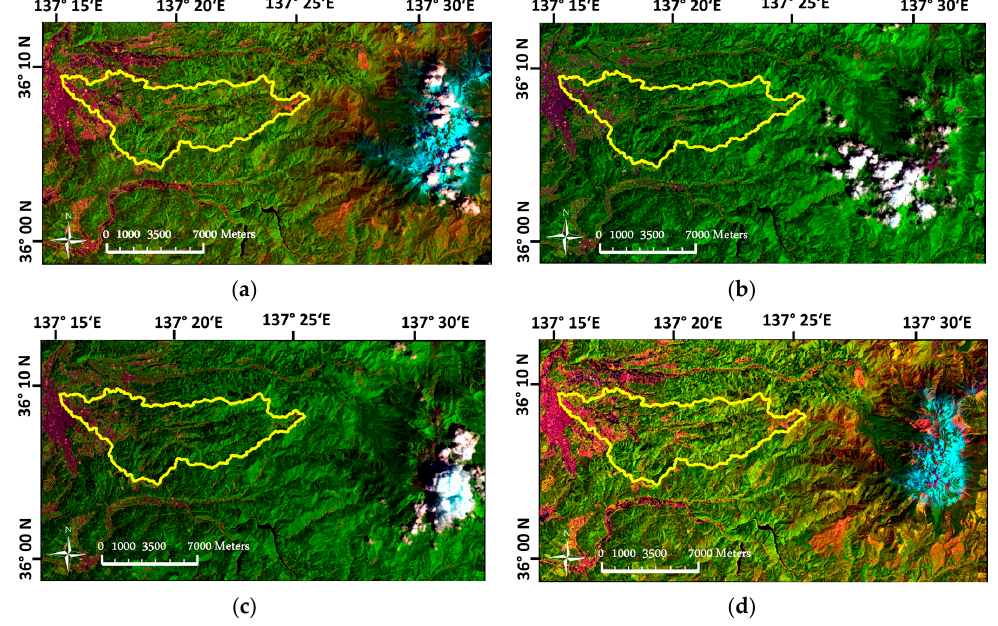
Figure 3. Original Landsat OLI sub-images dated 26 May 2013 ( a ); 14 August 2013 ( b ); 4 August 2015 ( c ); and 18 May 2016 ( d ). Yellow polygons denote the Daihachiga river basin. OLI bands 6, 5, and 4 are shown in red, green, and blue,